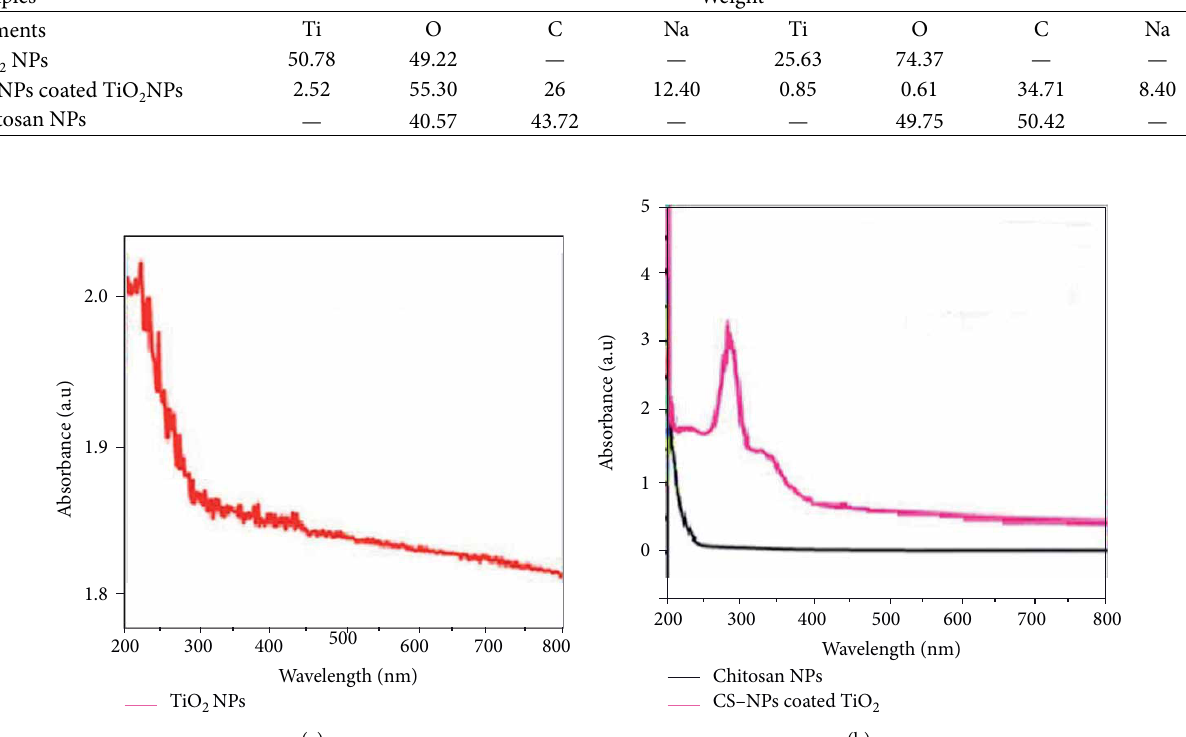
Figure 4: UV-Vis absorbance spectra of synthesized formulations. (a) TiO